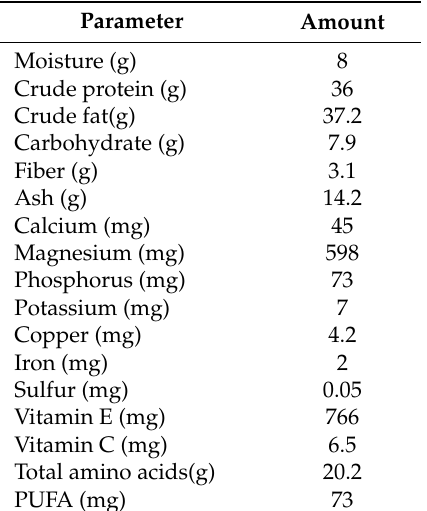
Table 1. Composition and nutrient content (per 100 g plant) of the Moringa oleifera seeds